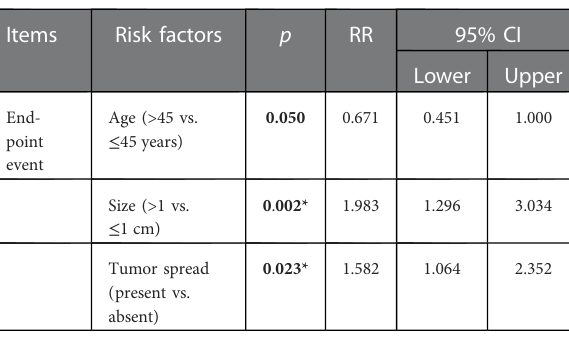
TABLE 4 Cox-regression analysis result of the overall recurrence (the recurrence of lymph nodes and neo-distant metastases was